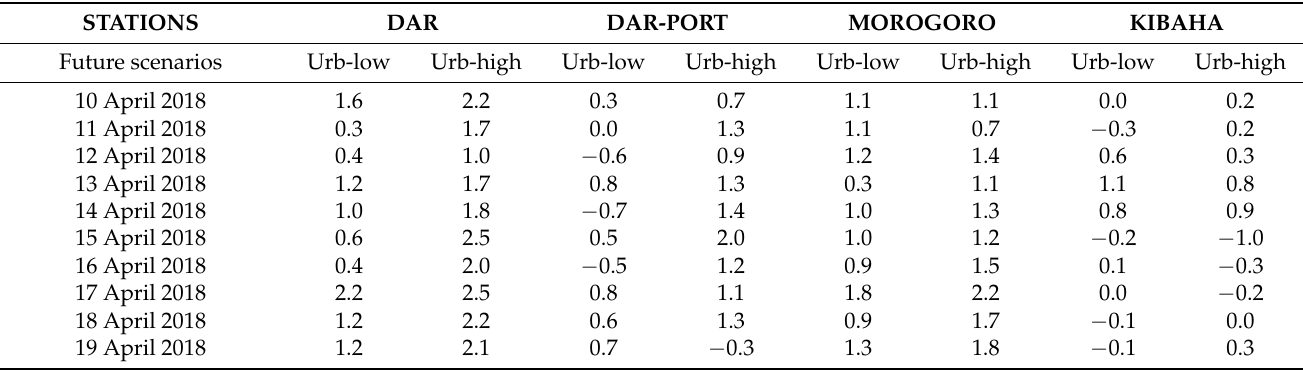
Table 5. Daily mean near surface air temperature difference ( ◦ C) for urbanization scenarios from the current LULC at four stations. STATIONS DAR DAR-PORT Future scenarios